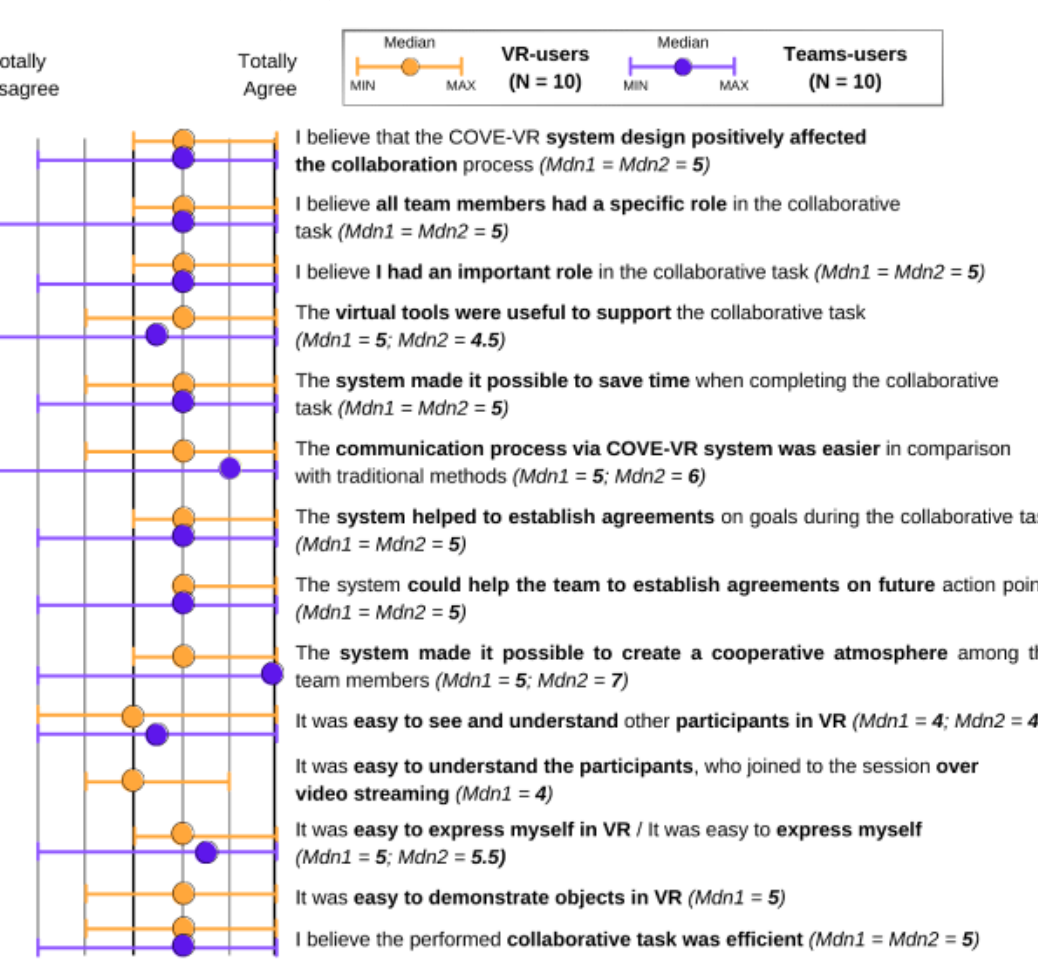
Figure 9. The results of the collaboration-related questionnaire.